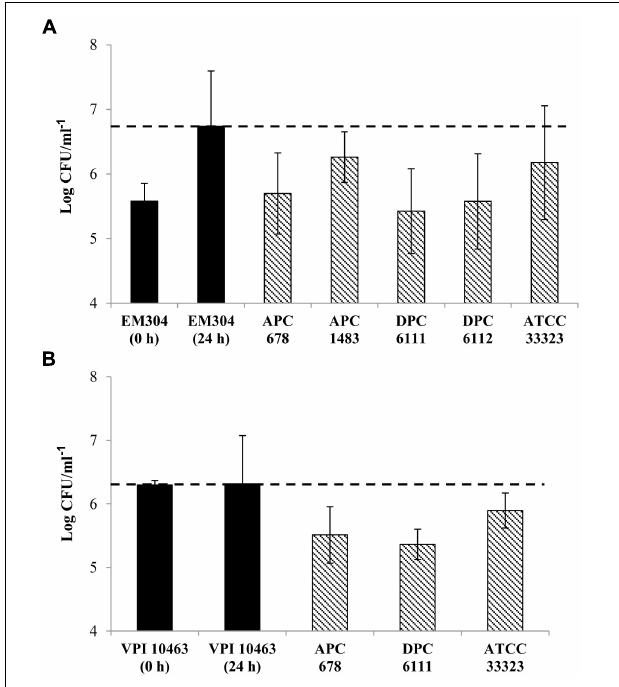
FIGURE 1 | Effect of probiotic lactobacilli on the survival of Clostridium difficile in co-culture. Black bars ( (cid:4) ) show the cell numbers of C. difficile at 0 and 24 h in the absence of Lactobacillus strains. Bars with dashed lines ( ) show the cell numbers of (A) C. difficile EM304 following 24 h co-culture with L. gasseri APC 678, L. paracasei APC 1483, L. rhamnosus DPC 6111, L. gasseri DPC 6112 or L. gasseri ATCC 33323 and (B) C. difficile VPI 10463 following 24 h co-culture with L. gasseri APC 678, L. rhamnosus DPC 6111 or L. gasseri ATCC 33323. The horizontal dashed line (---) indicates the final count of C. difficile at 24 h in the absence of the Lactobacillus strains. The average and standard error of the mean (SEM) of three independent repetitions are